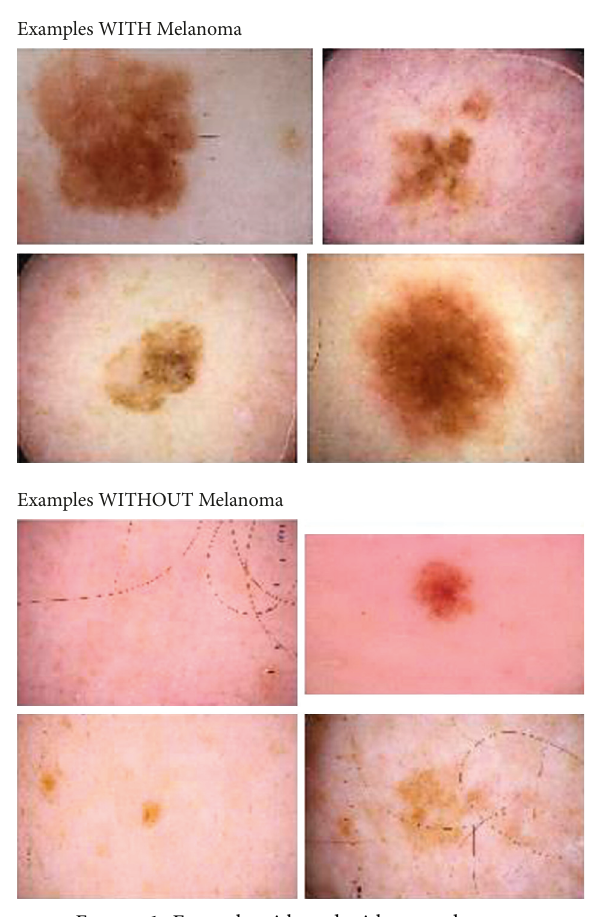
Figure 1: Example with and without